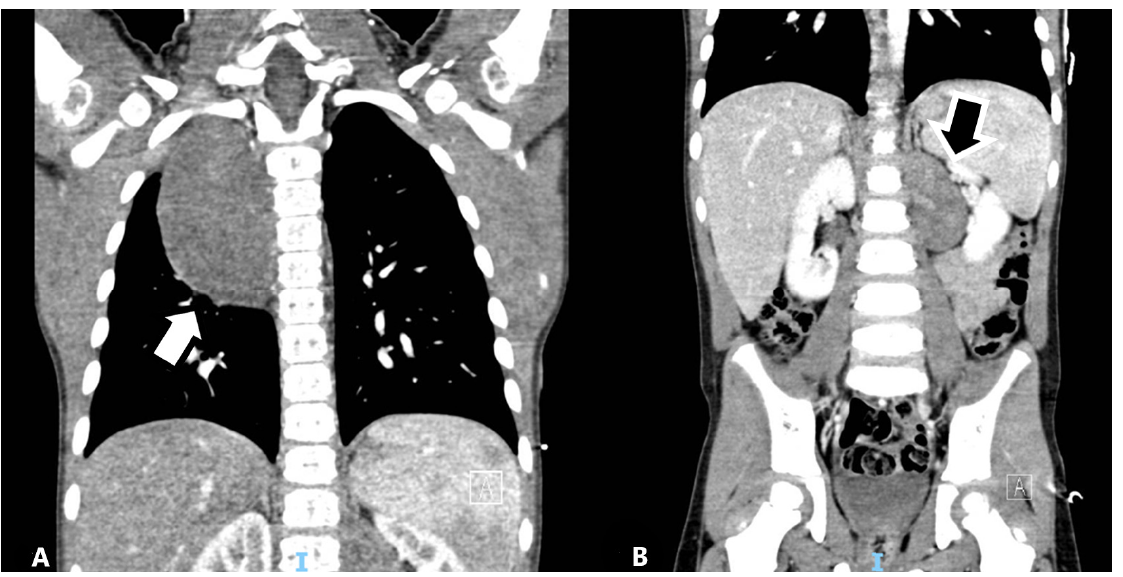
Figure 1. Computed tomography (CT) scan at diagnosis. The patient was a 4 ‐ year ‐ old male with a delay in the achievement of normal developmental milestones as well as scoliosis. Difficulty walking was noted, so an X ‐ ray of the spine was performed with the incidental finding of a mass located in the posterior mediastinum, making second ‐ level imaging such as CT necessary. The images show the presence of a right paravertebral mediastinal mass ( A ) measuring 5.5 × 4.5 × 8 cm (corresponding to a volume of 99 mL), oval ‐ shaped with homogeneous enhancement, and showed the presence of a second bilobed mass located at the left abdominal paravertebral level measuring 4.5 × 3.5 × 5.5 cm (corresponding to a volume of 43 mL) with similar CT features ( B ). At the thoracic level, the mass was in contact with the right main bronchus and the terminal part of the azygos vein, with no apparent infiltration of adjacent organs and structures; the abdominal lesion reached the kidney ileus with strict contact with both renal vein and artery.